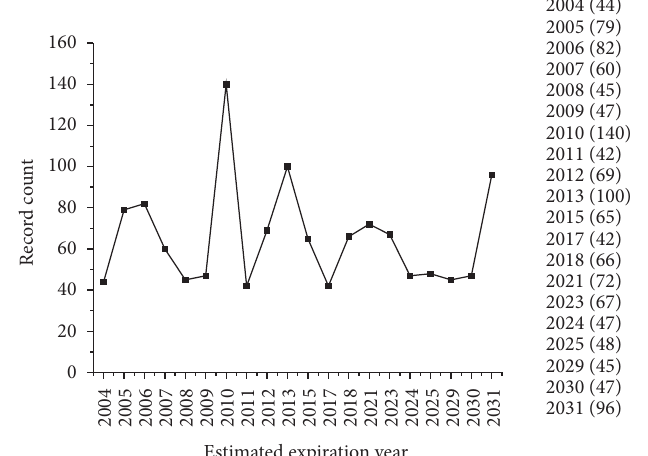
Figure 8: Estimated expiration year of the publications.